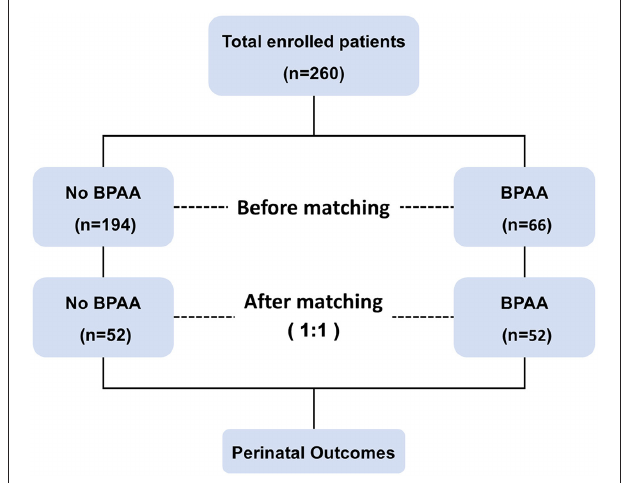
FIGURE 1 | Flowchart of the study. BPAA, balloon placement of abdominal